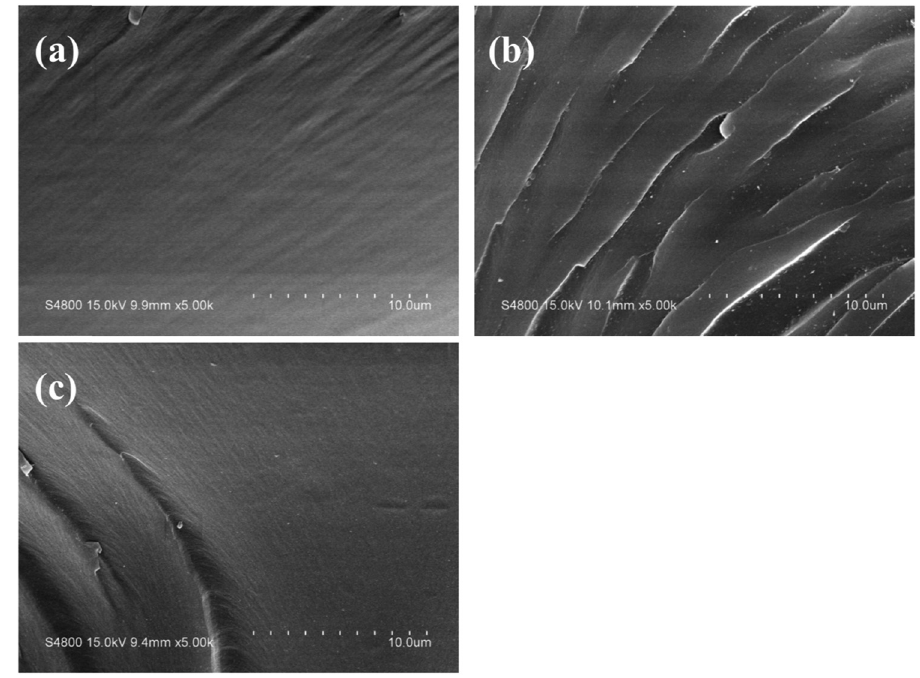
Figure 7: SEM images of PTA resin and POSS - PTA resins: ( a ) PTA, ( b ) OADTP - PTA - 16, ( c ) OADTP - PTA -